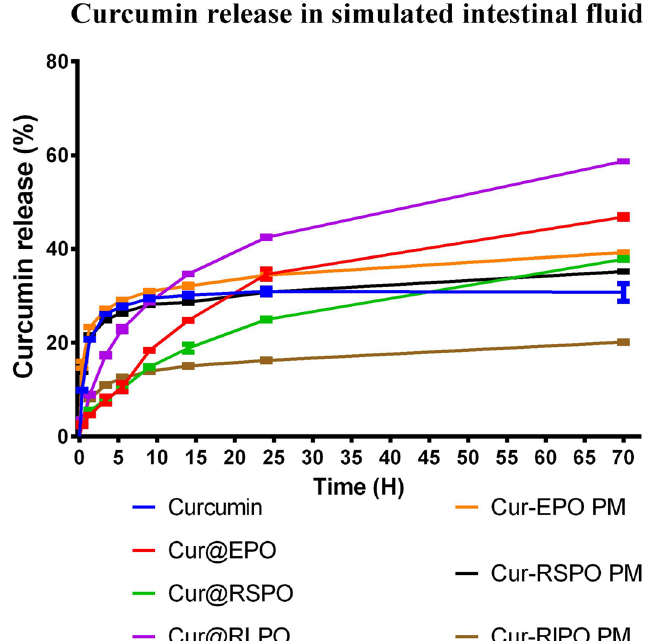
FIGURE 6 - Release profile in simulated intestinal fluid (SIF) of curcumin, curcumin Eudragit E PO solid dispersion, curcumin Eudragit RS PO solid dispersion, curcumin Eudragit RL PO solid dispersion, curcumin and respective acrylic polymer including curcumin Eudragit E PO physical mixture (Cur-EPO PM), curcumin Eudragit RS PO physical mixture (Cur-RSPO PM) and curcumin Eudragit RL PO physical mixture (Cur-RLPO PM). Each text was repeated three